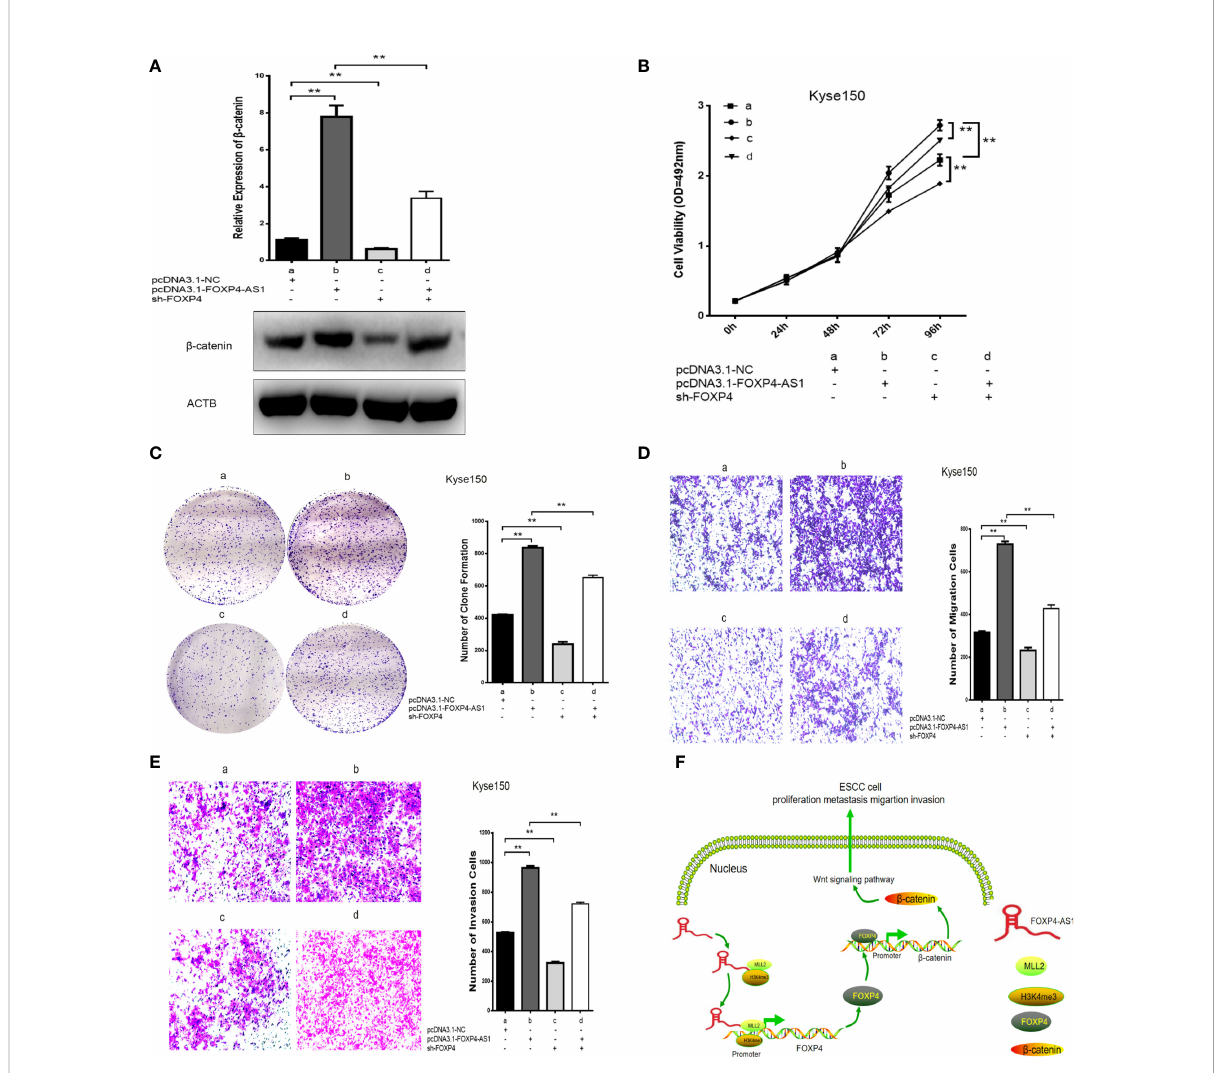
FIGURE 7 Coexpression of FOXP4-AS1 and FOXP4 promotes b -catenin expression and ESCC progression. (A) The mRNA and protein levels of b -catenin with FOXP4-AS1 and FOXP4 by qRT ‐ PCR or WB. The effect of FOXP4-AS1 and FOXP4 coexpression on ESCC cell proliferation by MTS (B) or Colony formation (C) assay. FOXP4-AS1 and FOXP4 coexpression on ESCC cell migration (D) and invasion (E) by Transwell assay. (F) The possible molecular mechanisms for the involvement of FOXP4-AS1 in ESCC progression. ** p <